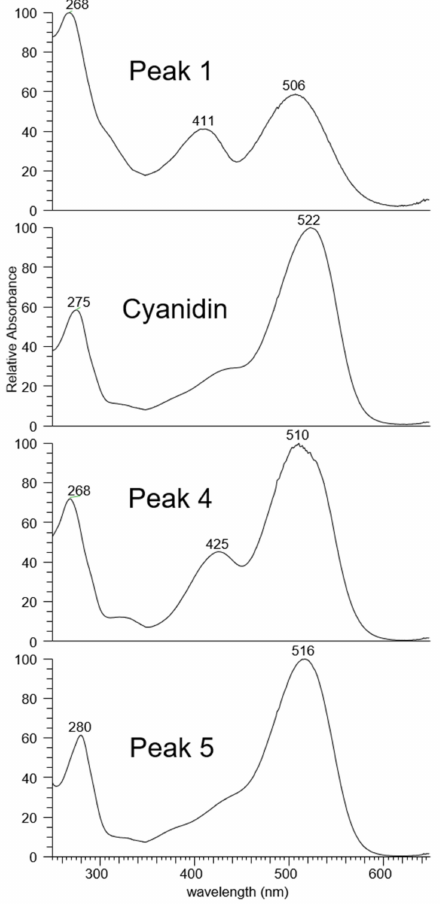
Figure 2. UV/Vis spectra of cyanidin (RT 11.7 min) in comparison to three cyanidin monosulfates (RT 7.1, 12.6 and, 12.8